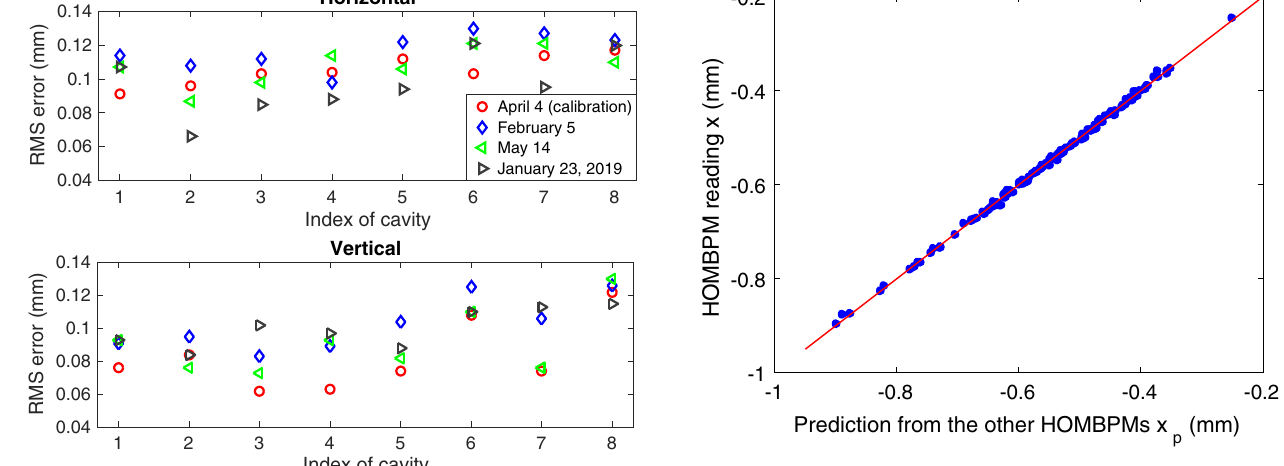
FIG. 15. Result of the RMS error for eight cavities in horizontal plane (top) and vertical plane (bottom). Data was obtained from four different measurements.